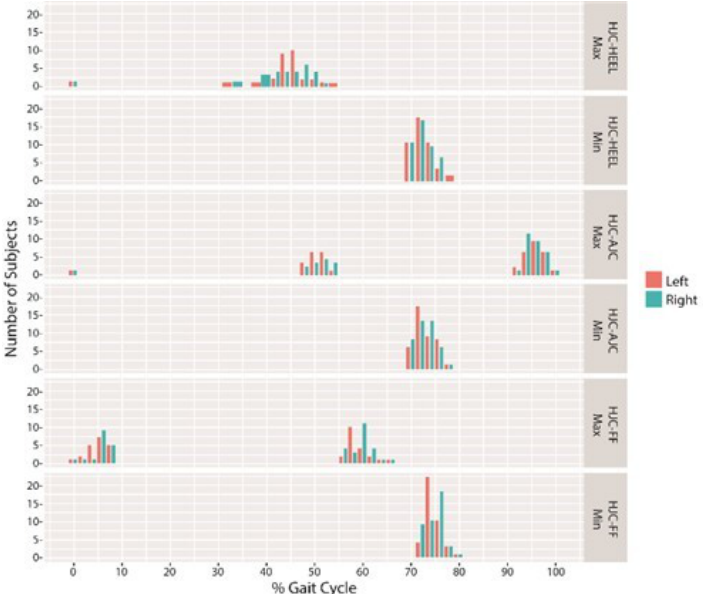
Figure 5. Time of maximal and minimal DLLs during the gait cycle.